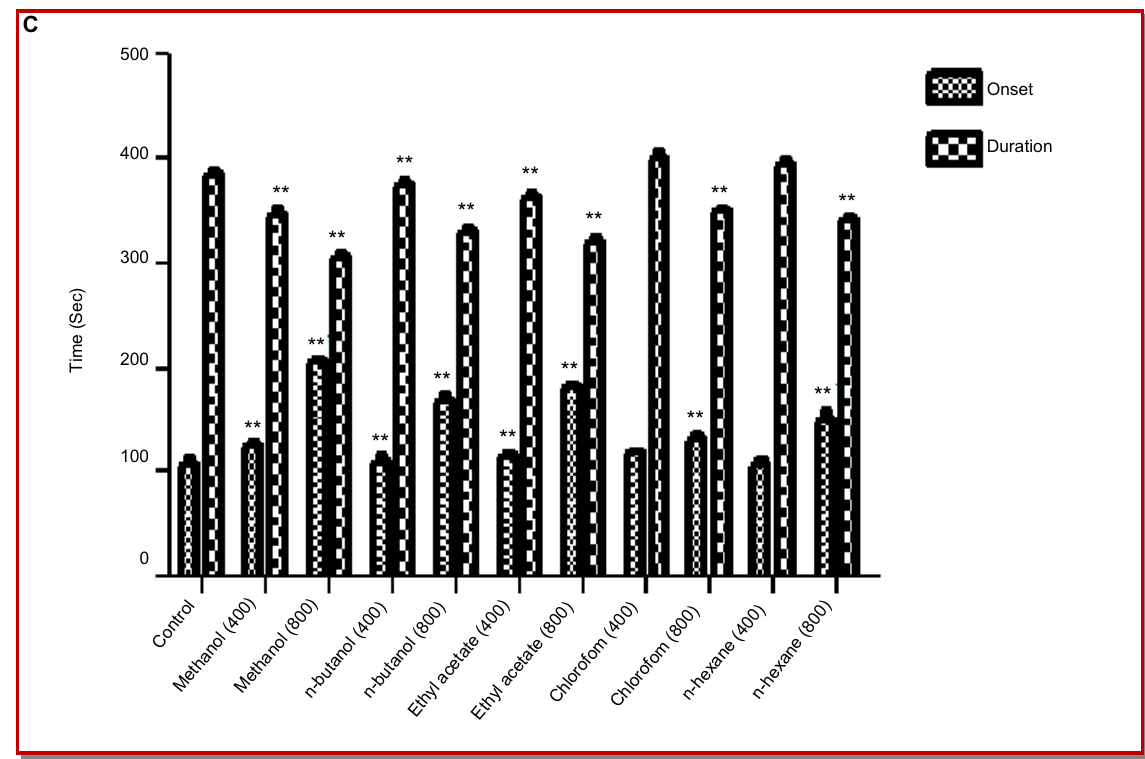
Figure 1: Anticonvulsant effect of A. rosea extract and fractions against PTZ (A)- , strychnine (B) – and picrotoxin (C)-induced con- vulsions; Mean ± SEM; n=6; *p<0.05, **p<0.01 when compared with control